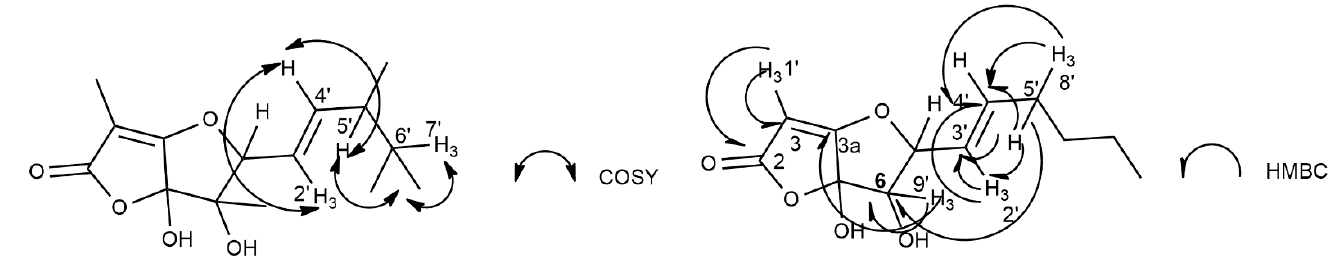
Figure 2. The most significant COSY and HMBC correlations observed in the corresponding spectra of 1 .